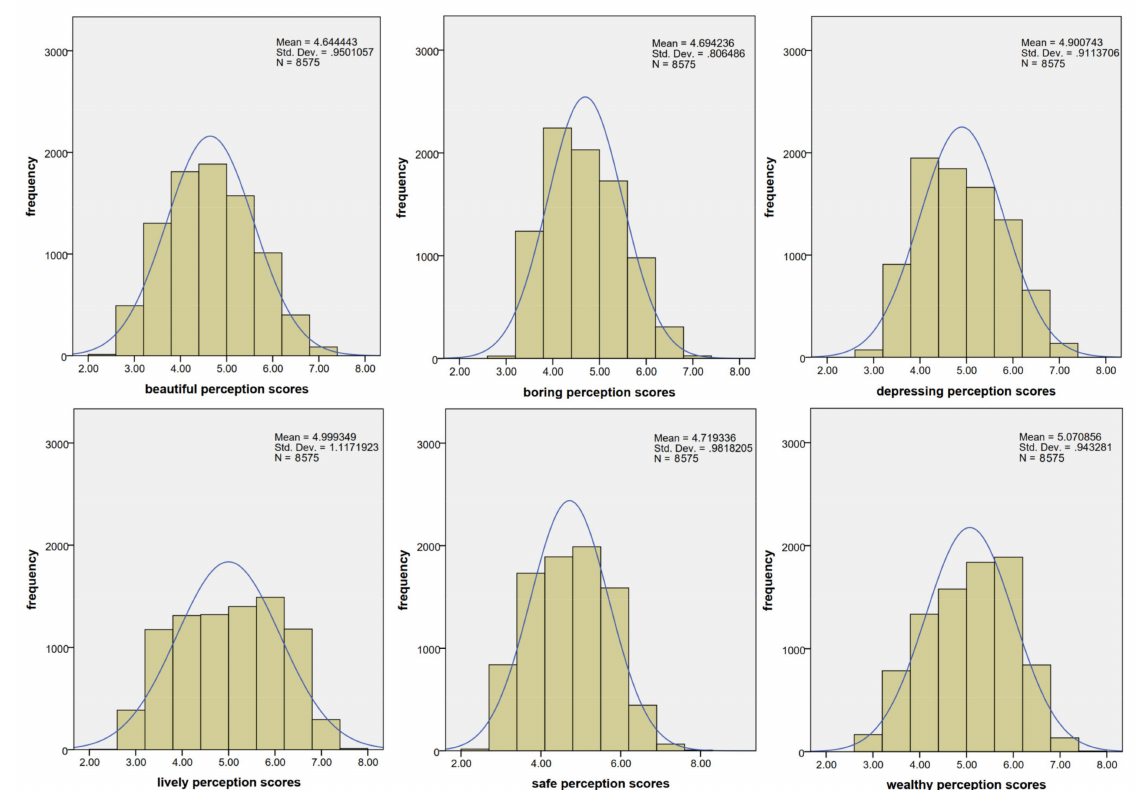
Figure 9. Histogram distribution of human perceptions of